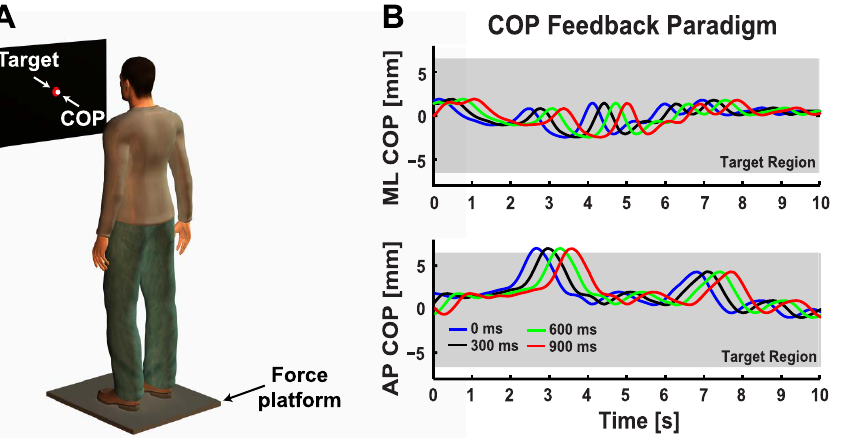
Figure 1. Experimental apparatus and delayed visual feedback paradigm. A. Schematic of the experimental setup showing the participant standing on the force platform in a comfortable shoulder-width posture with their arms placed at their sides. The visual display was located at eye level in front of the participant and displayed a fixed red circle (13 mm radius) corresponding to the target COP position. In the visual feedback conditions, a white cursor (10 mm radius) displayed the real time (instantaneous visual feedback, 0 ms delay) or delayed (300, 600, 900 ms visual feedback delay) COP position. Participants were instructed to position their COP on the fixed target as accurately as possible throughout the trial. B. Representative data taken from a single trial (31 seconds) performed by a young subject to illustrate how the feedback delay influenced the COP position shown on the visual display. Ten seconds of COP data are plotted to show the effect of the visual feedback delay. The blue traces are the true mediolateral (ML COP, top panel) and anteroposterior (AP COP, bottom panel) COP position displayed in the 0 ms visual feedback delay condition. The black (300 ms delay), green (600 ms delay) and red (900 ms delay) traces correspond to what was shown on the visual display in the delayed visual feedback conditions. Shaded grey region corresponds to the boundaries of the fixed COP target.